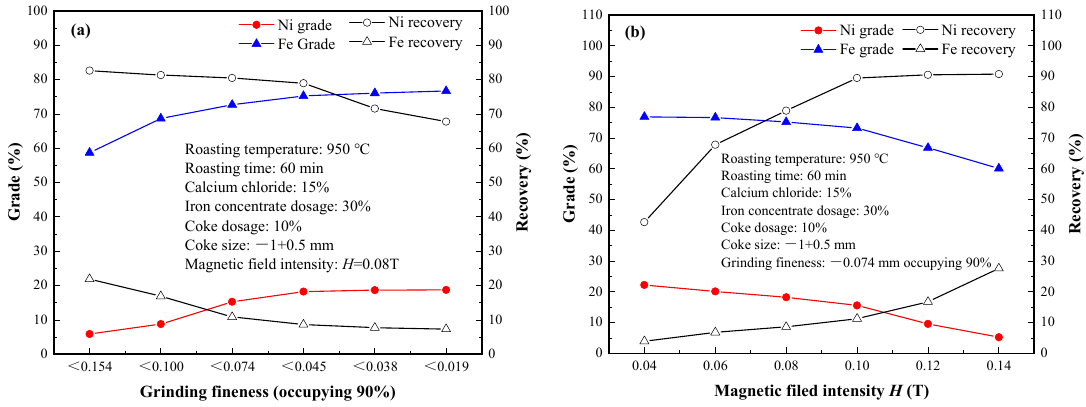
ff ect of grinding fineness ( a ) and magnetic field intensity ( b ) on nickel Figure 6. Effect of grinding fineness ( a ) and magnetic field intensity ( b ) on nickel extraction. Figure 6. E